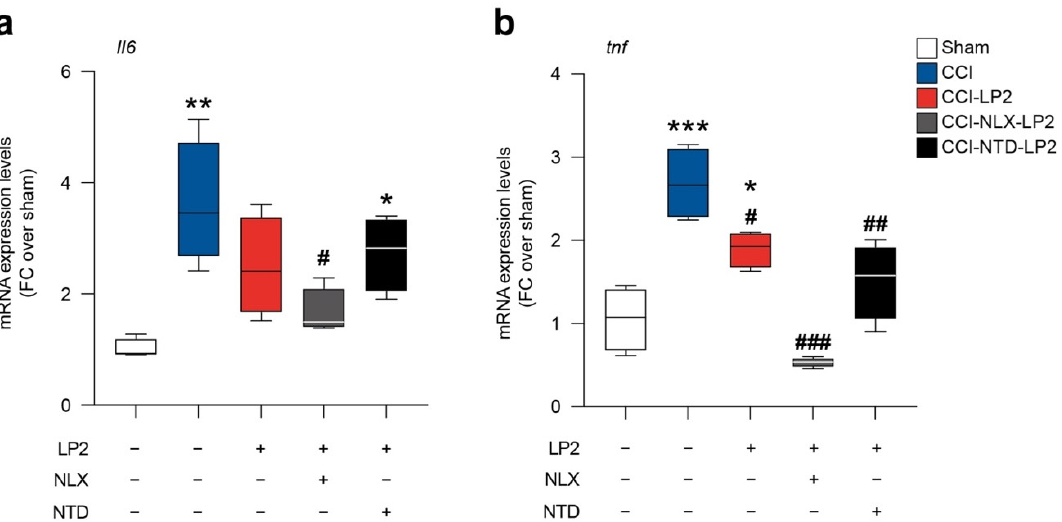
Figure 6. Il6 ( a ) and tnf ( b ) mRNA levels on sham, CCI, CCI-LP2, CCI-NLX-LP2, CCI-NTD-LP2 spinal cords. CCI: chronic constriction injury; NLX: naloxonazine; NTD: naltrindole; FC: fold change. * p -value < 0.05, ** p -value < 0.01, and *** p -value < 0.001 versus sham. # p -value < 0.05, ## p -value < 0.01 and ### p -value < 0.001 versus CCI.